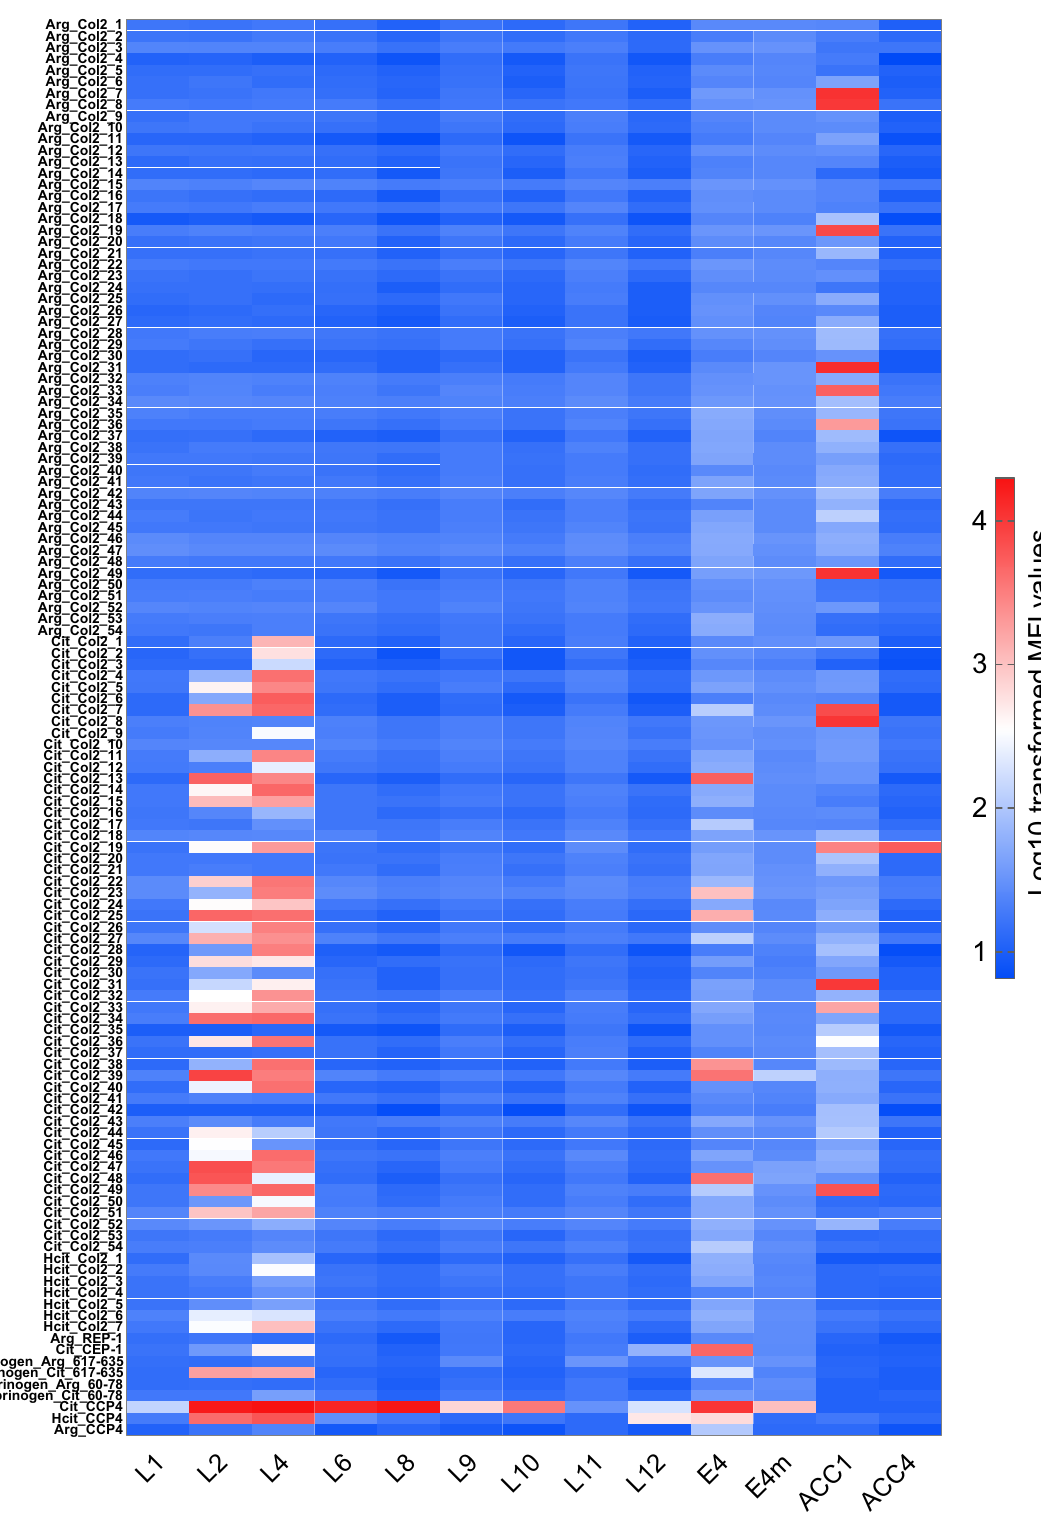
peptides, analysis of antibody speci fi cities was carried out using established bead- based multiplex immunoassay (Luminex) and Log10-transformed MFI values at 1.0 μ g/ml antibody concentration are presented as heatmap.